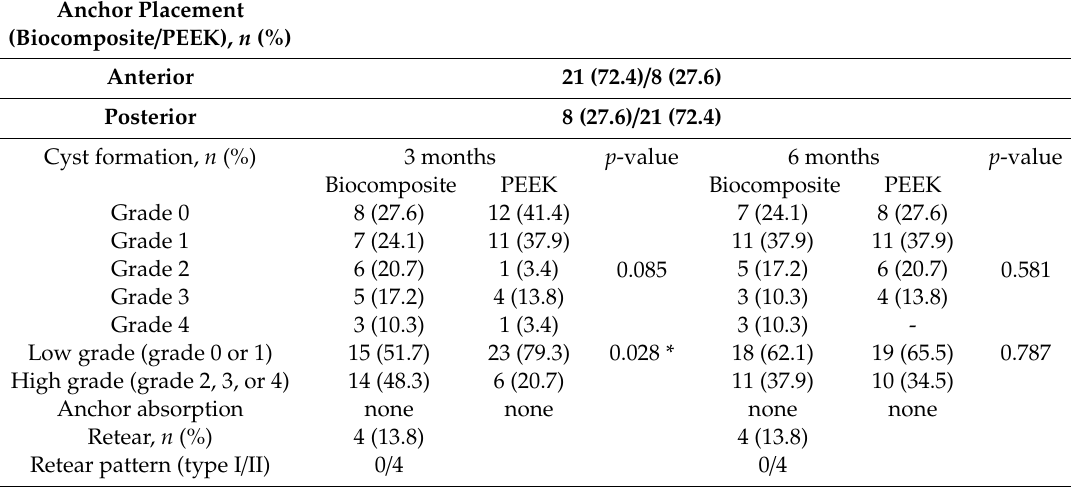
Table 4. Results of perianchor cyst